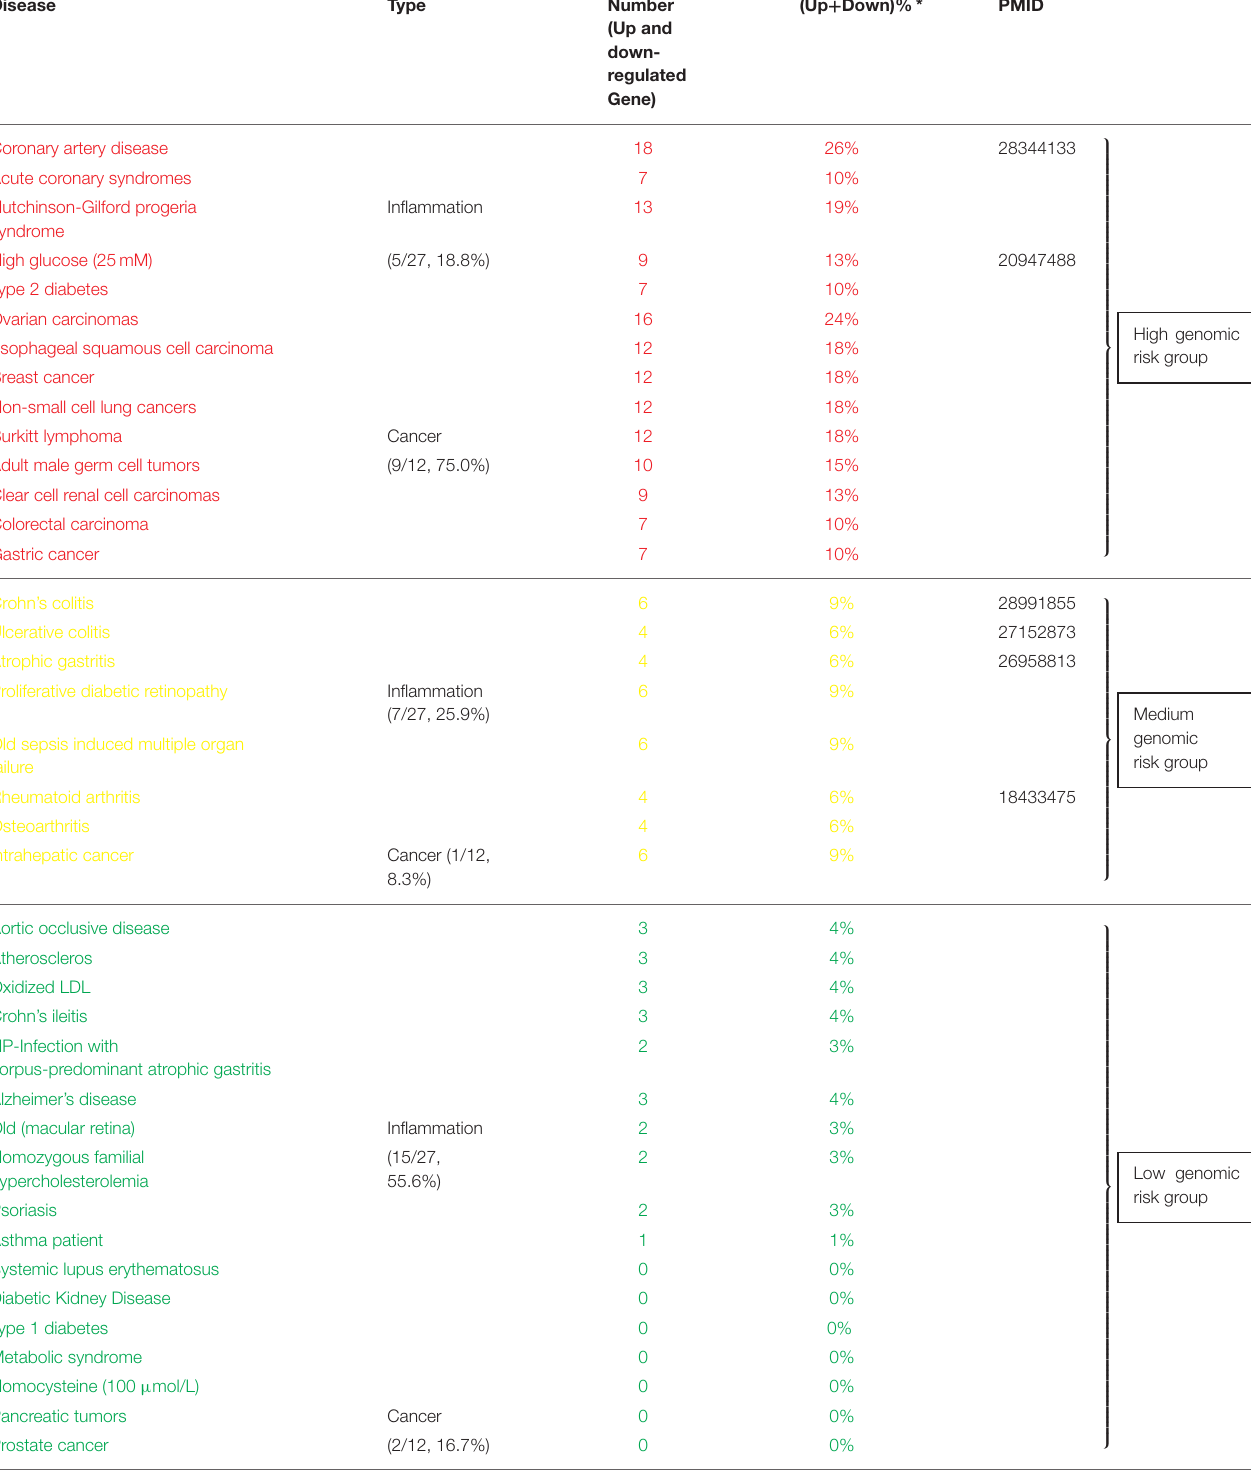
(Up + Down)%* PMID (Up and down- regulated Gene)